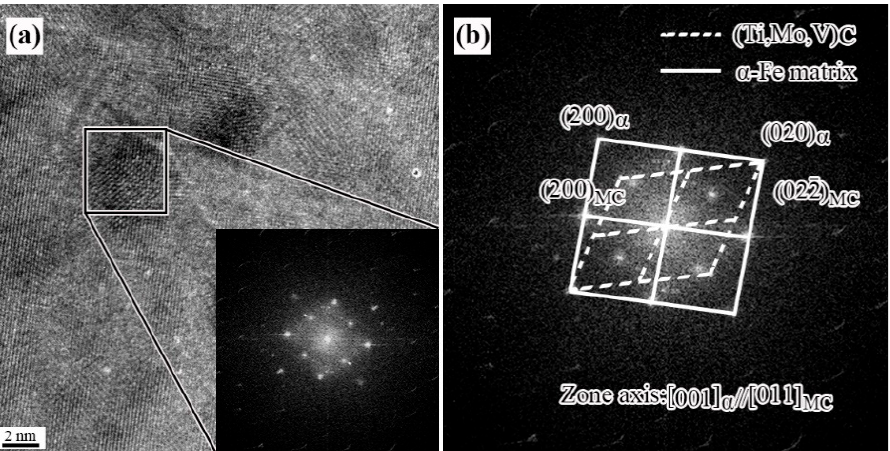
Figure 4. ( a ) High resolution TEM micrograph of the precipitation and ( b ) fast Fourier trans- formed.